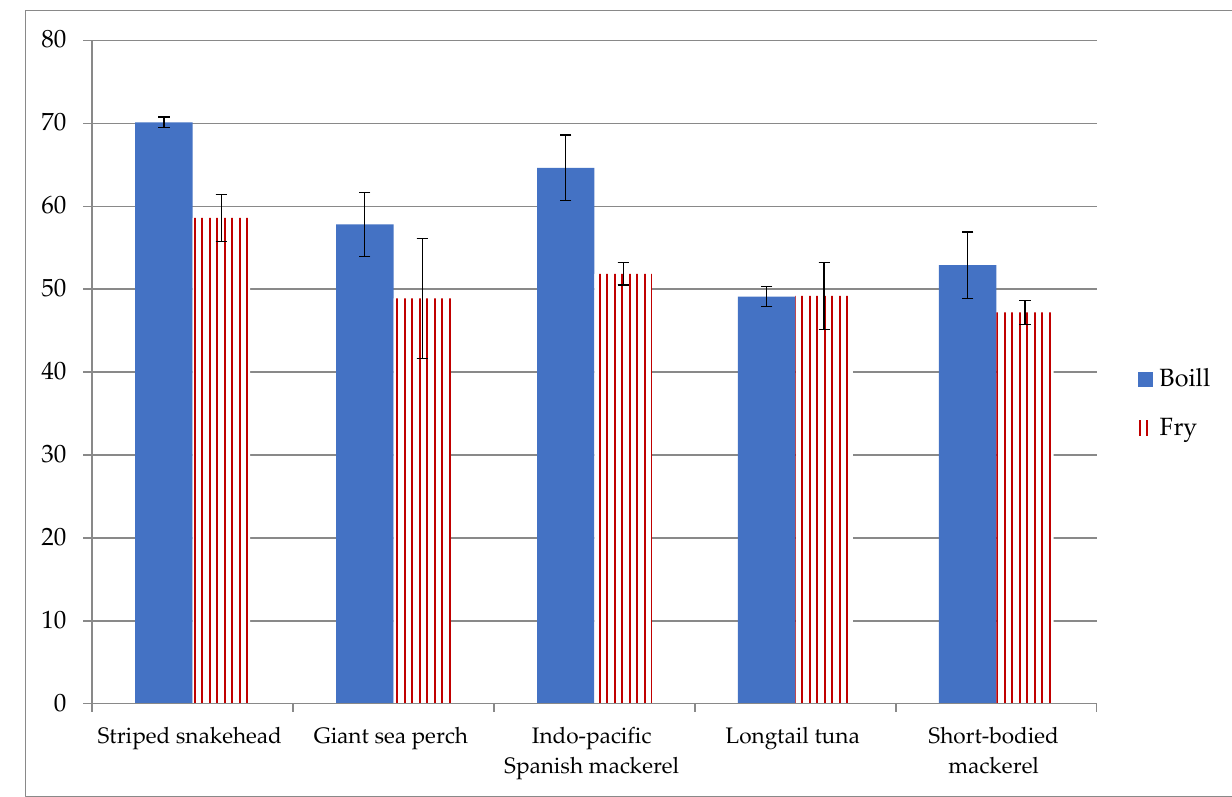
Figure 2. Value of percentage of in vitro bioaccessibility of Se obtained in boiled and fried fish. Table 6. Estimated marginal means of % of in vitro bioaccessibility of Se by the major impacts of different fish species and cooking techniques ( n = 3).